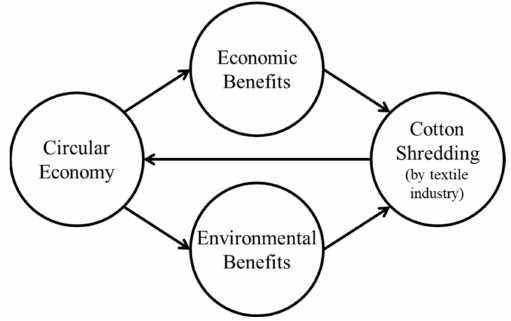
Figure 3. Conceptual model.